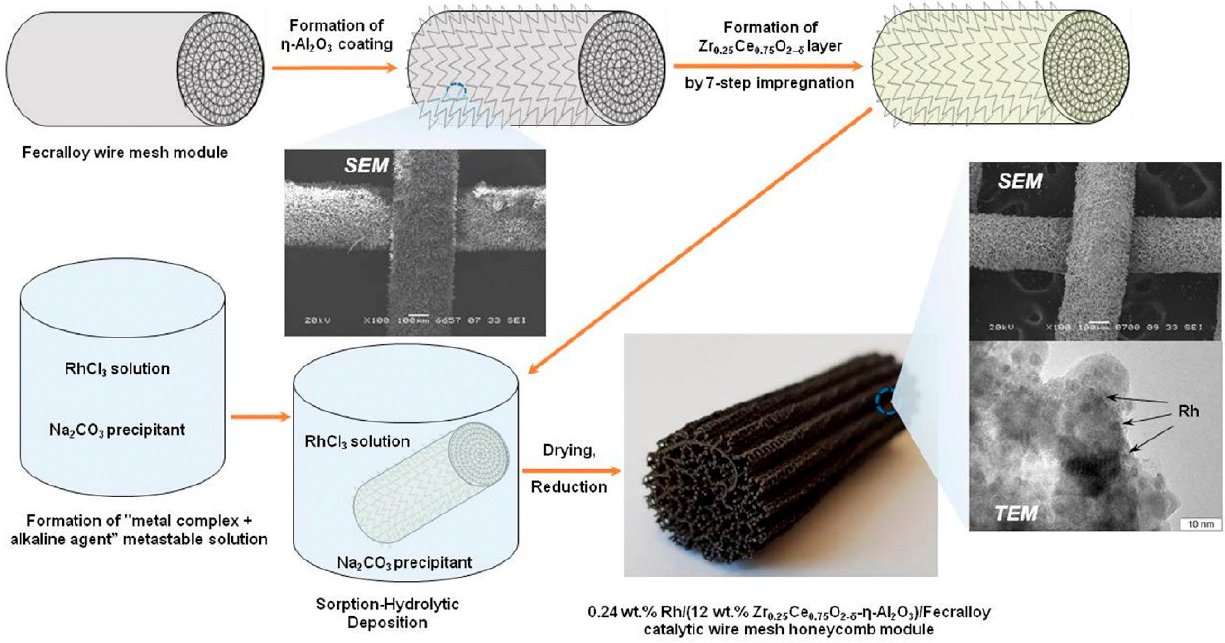
Figure 6. Schematic preparation procedure of Rh/CZB/FCA catalytic block, its general view, SEM and TEM images [51]. and TEM images